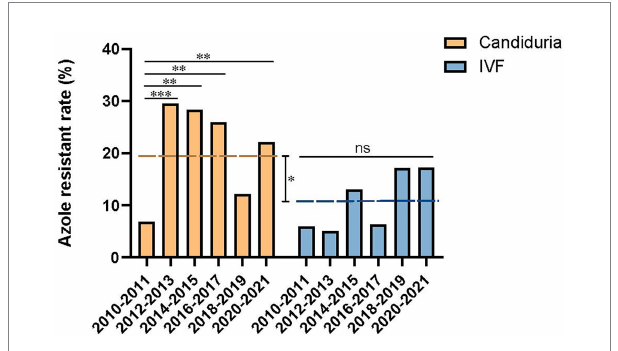
FIGURE 2 Temporal changes of azole resistance of C. tropicalis isolated from candiduria and invasive infection (IVF) patients. The dashed line indicates the overall fluconazole resistance rates of latter nine surveillance years’ period (2012–2021). * p < 0.05, ** p < 0.01, *** p < 0.001, and ns, not significance.